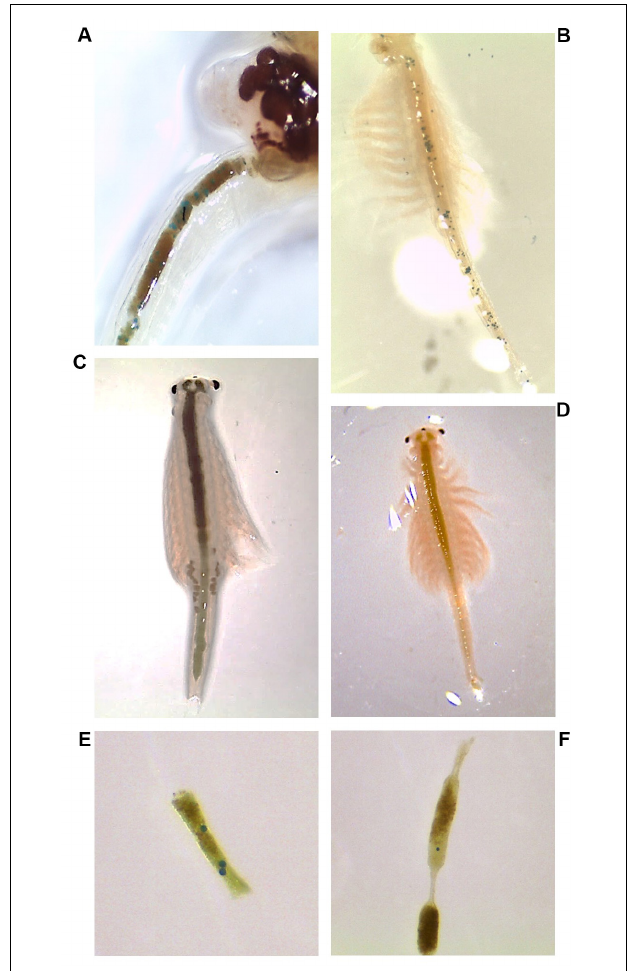
FIGURE 1 | Particle ingestion and egestion by Artemia . (A) Particles present in the Artemia digestive tract after 2 h of exposure. One black microfiber can be seen close to blue microbeads. (B) Trophic chain experiment: Artemia after exposure to microbeads and before being fed to fish. (C) Artemia exposed to particles in the presence of food: the upper digestive tract is filled with food, preventing the observation of microbeads, and microfibers potentially ingested. (D) Artemia after 96 h of depuration. (E,F) Microbeads observed in Artemia